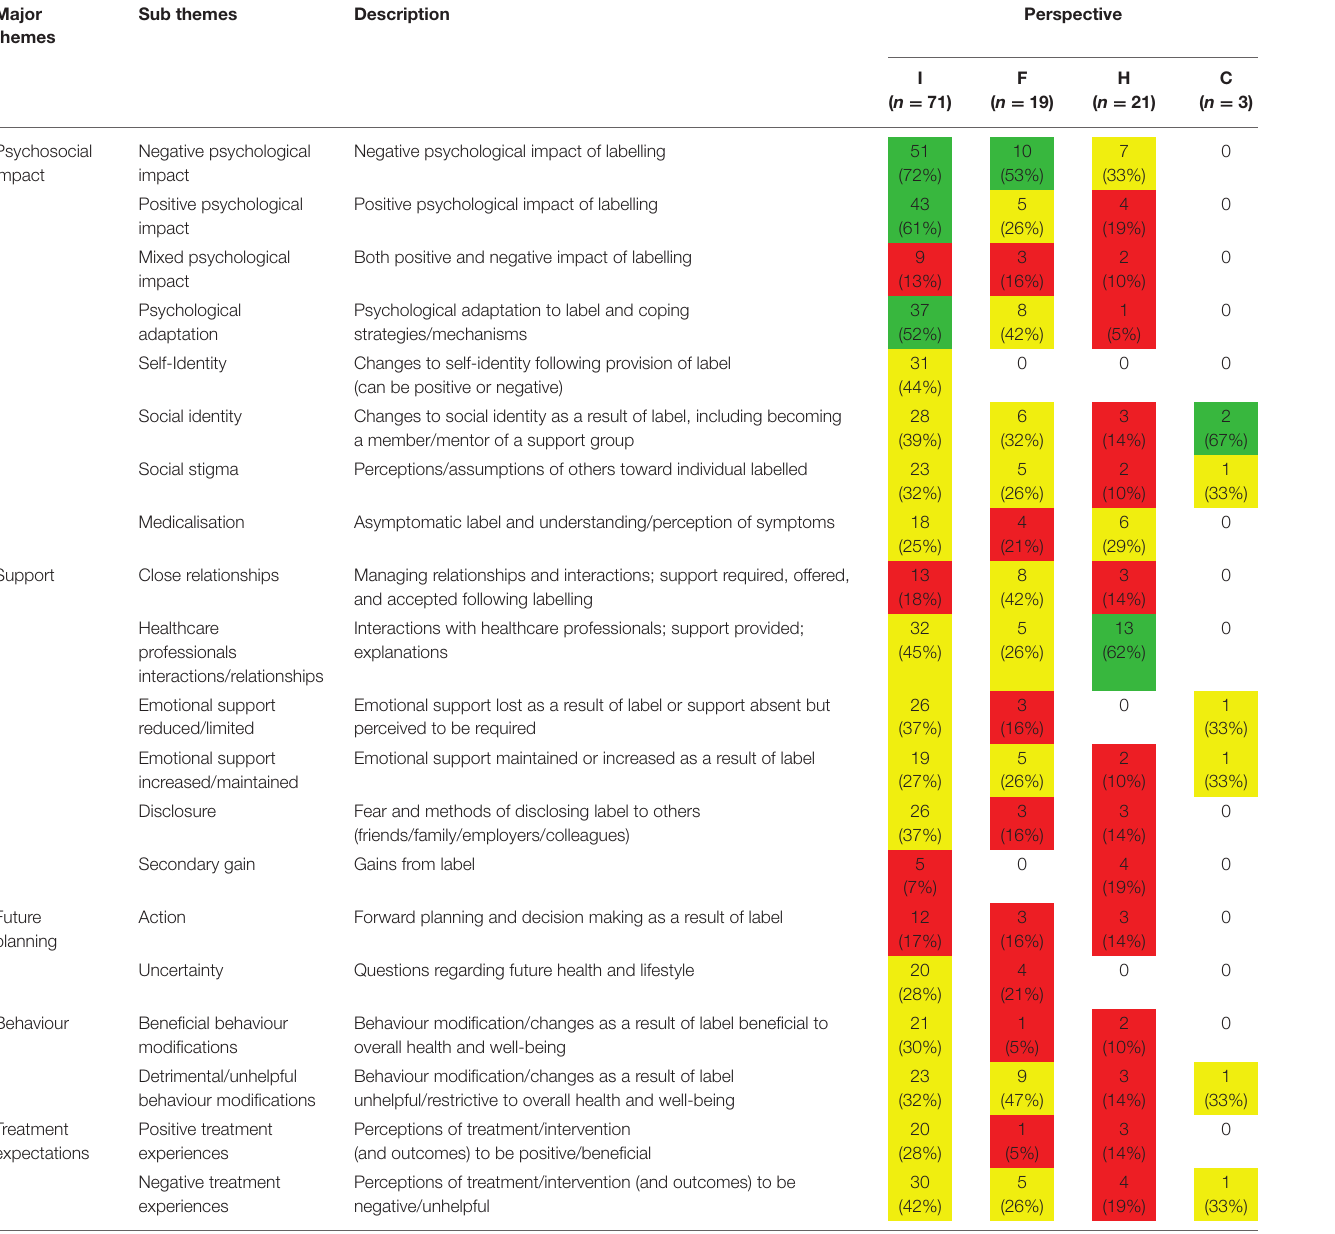
TABLE 2 | Proportion of records supporting each theme from the various